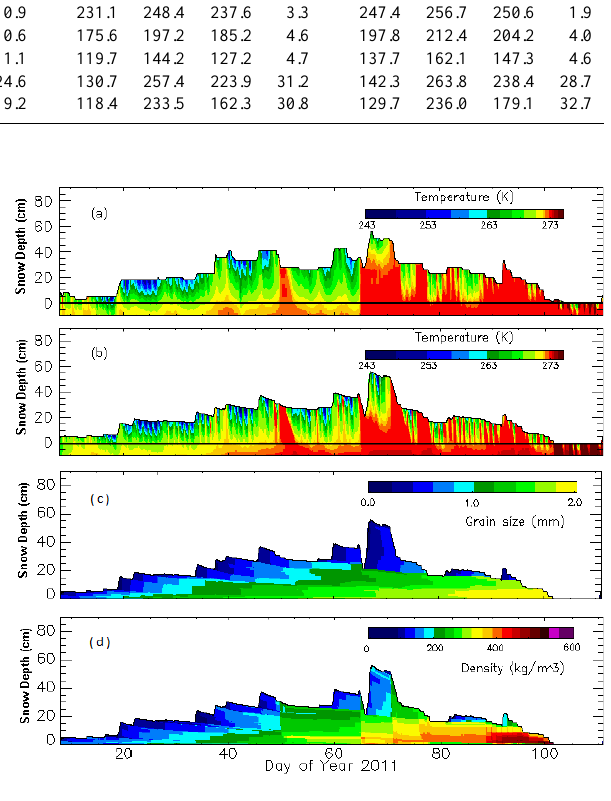
Fig. 7. Comparison of (a) observed temperature with (b) simulated snowpack temperature, (c) simulated snow grain size and (d) simu- lated snow density at varying snow